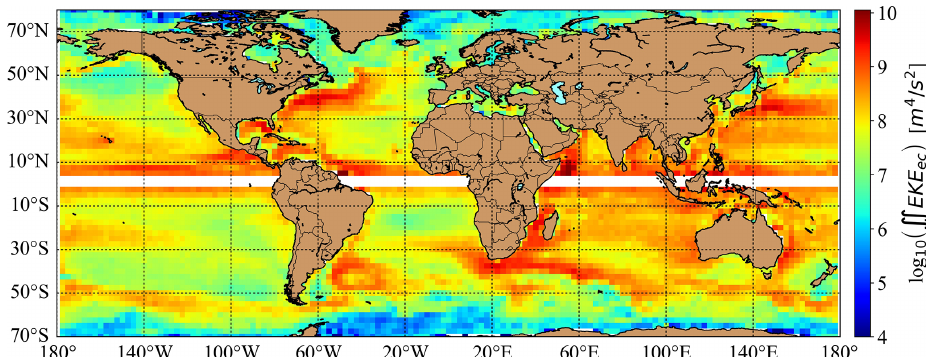
Figure 5. Temporal mean eddy kinetic energy (cid:82)(cid:82) EKE ec estimated from the squared amplitude parameters η 2 ec of the eddy census by Eq. (3) for the tiling of 11 × 11 grid cells. The white band indicates the equatorial region where estimates diverge because the Coriolis parameter ∼ sin (ϕ) in the denominator of Eq. (3) tends to zero. The color scale is logarithmic for better visualization.